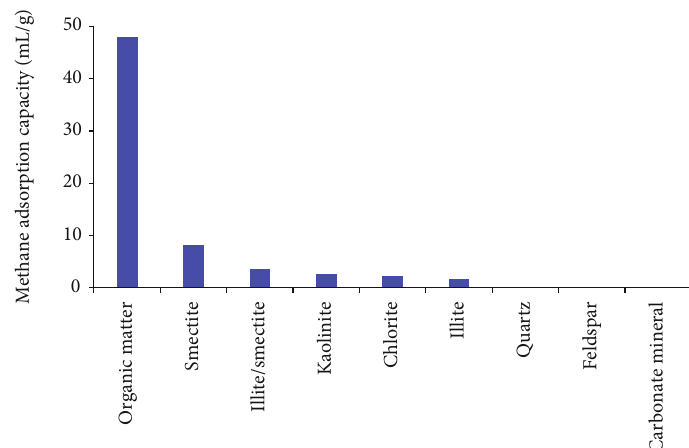
Figure 5: Methane adsorption capacity of di ff erent components. Organic matter has a signi fi cantly higher methane adsorption capacity than other components. Brittle minerals have the lowest adsorption